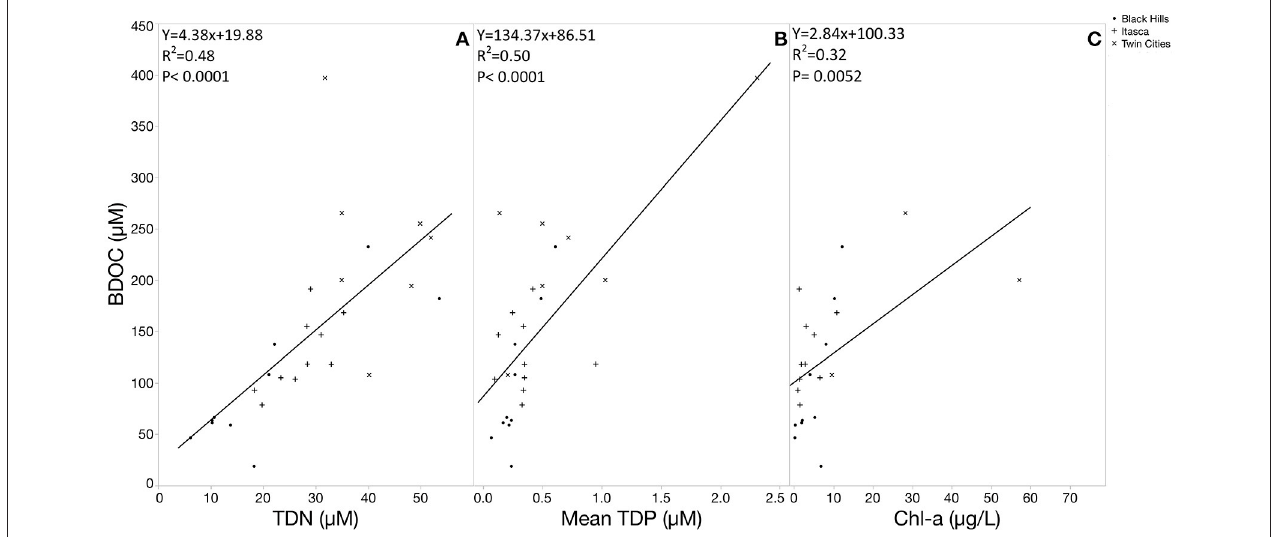
FIGURE 10 | Linear regression functions showing the relationship between BDOC concentration and trophic status indicators. Strong positive relationships between BDOC and TDN (A) and TDP (B) suggest BDOC accumulation in high nutrient conditions. BDOC is also positively correlated with productivity, measured as chlorophyll-a concentration (C)